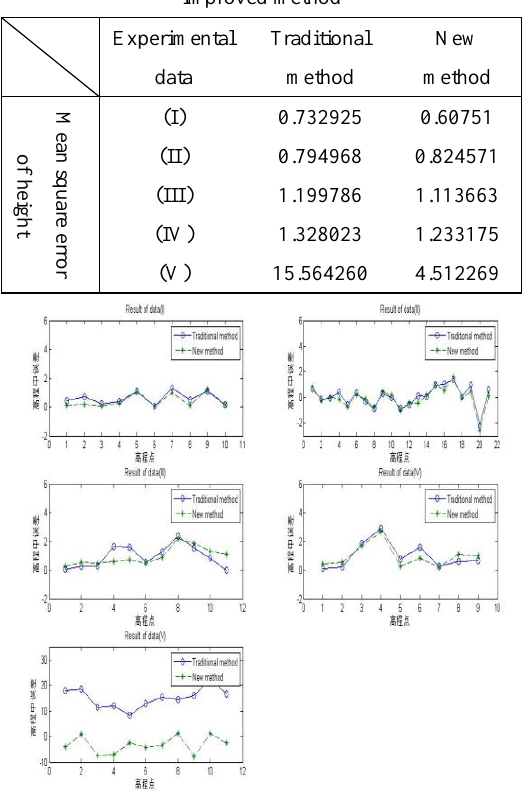
Figure 3. Results of two